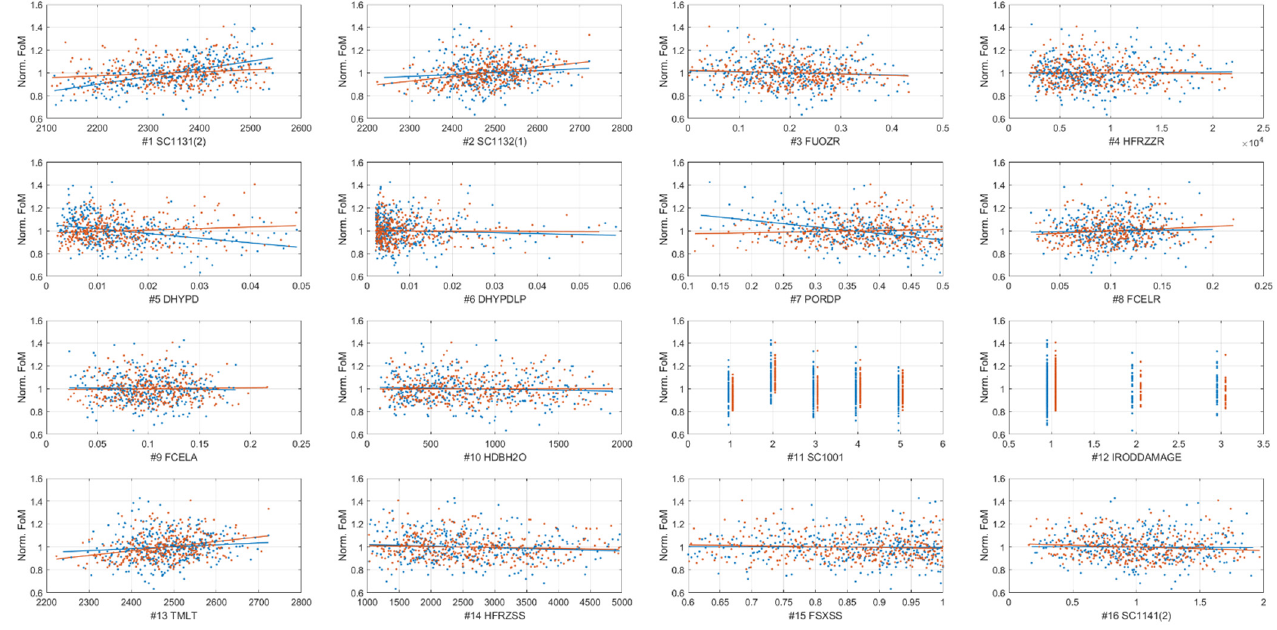
Figure 14. Hydrogen (FoM) mass normalized to average final FoM vs. uncertainty parameters with fitted linear regression for PWR reactor. Blue is the top peaked profile, and red is the FPT-like profile. All FoM results are for the final core state. Normalization by the FoM mean value.